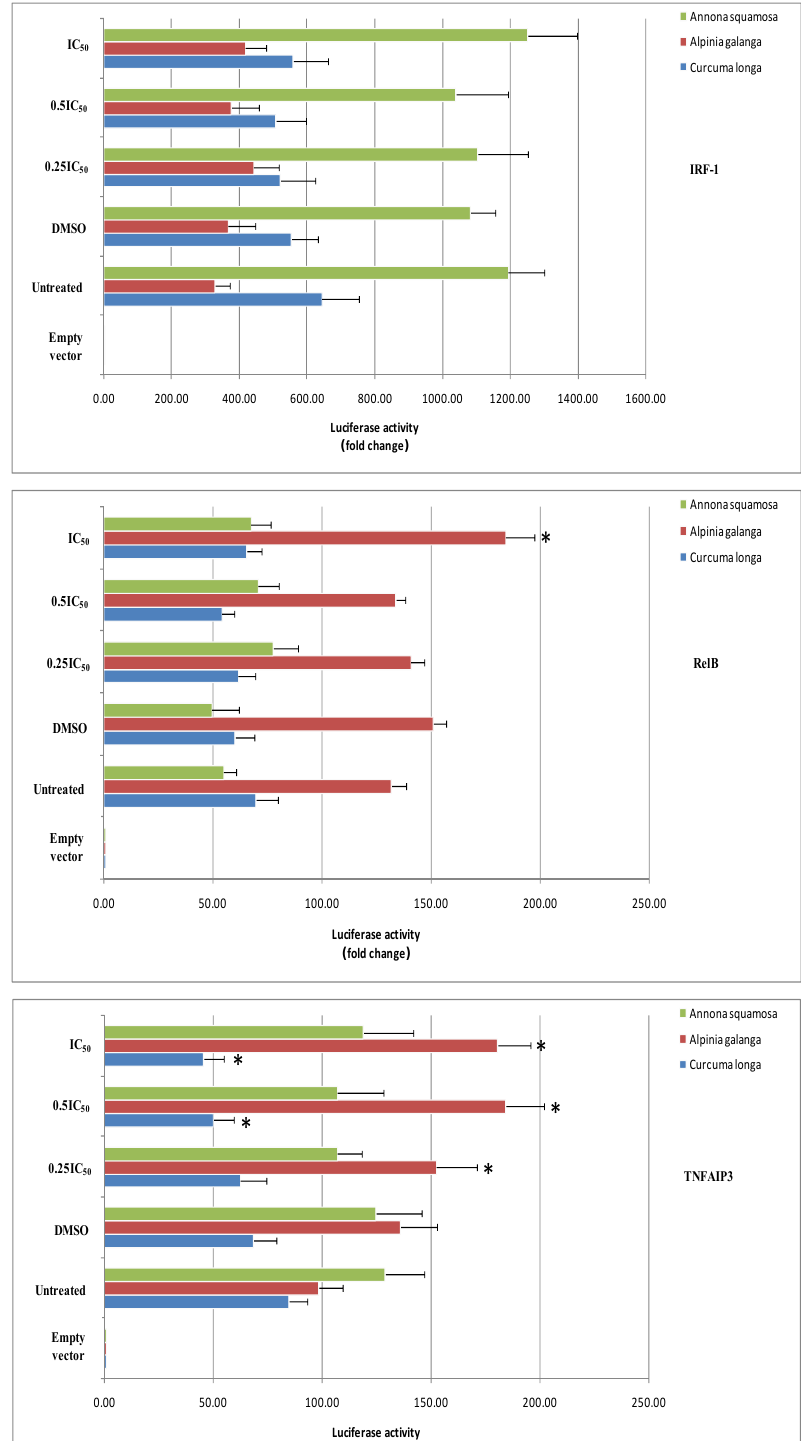
Figure 4. The effect of Thai medicinal herb extracts on promoter activity of NF- κ B signaling network genes in HaCaT cells pretreated for 12 h with both proinflammatory cytokines and treated for 24 h with increasing concentrations of each herbal extract